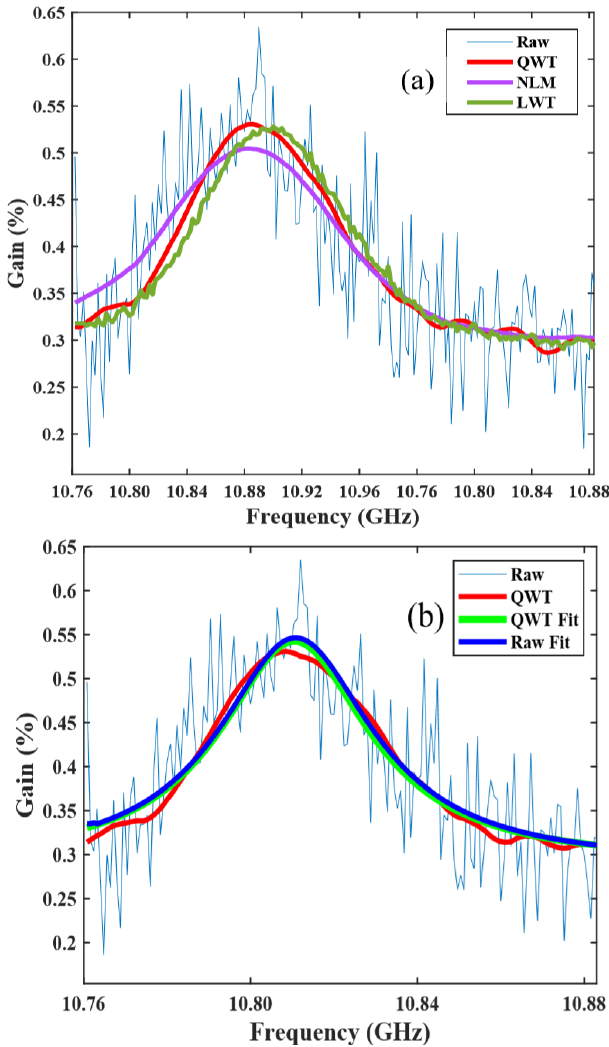
Figure 6. D i ff erent BGS curves ( a ) and BGS curves by LCF ( b ). Figure 6. Different BGS curves ( a ) and BGS curves by LCF ( b ).